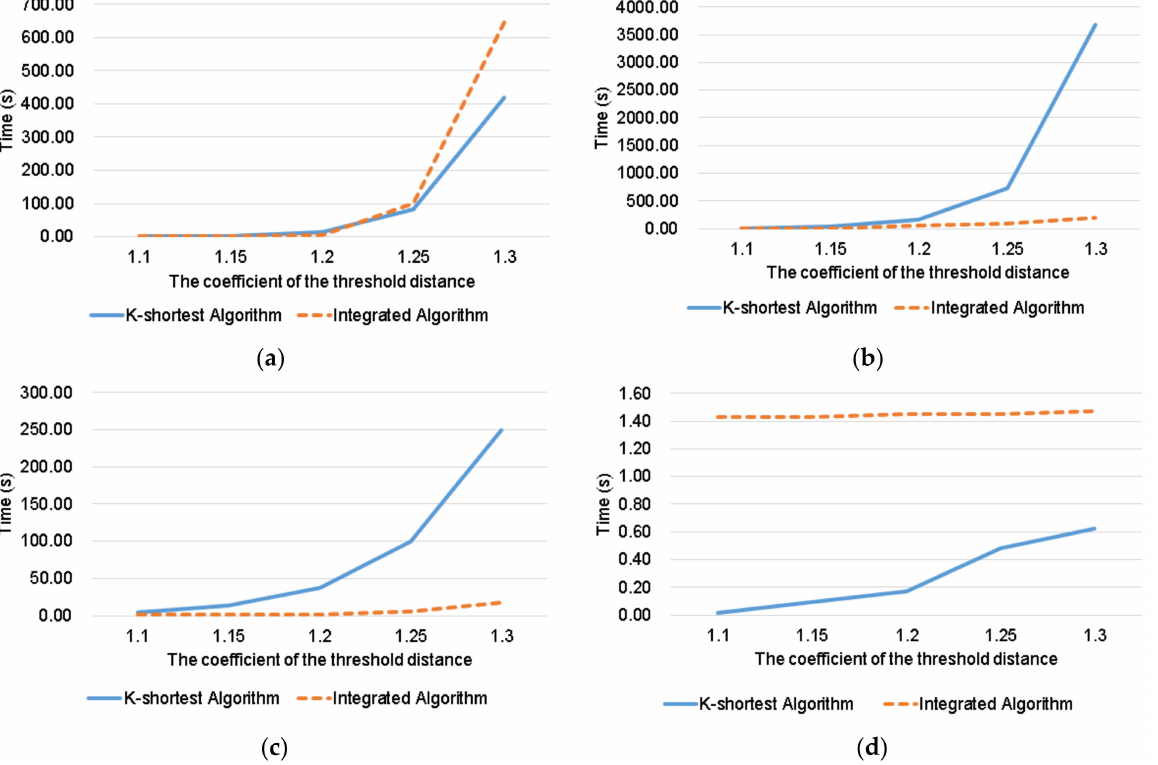
Figure 5. Computational time for the route from ( a ) points 1 to 75. ( b ) points 4 to 74. ( c ) points 7 to 82. ( d ) points 48 to